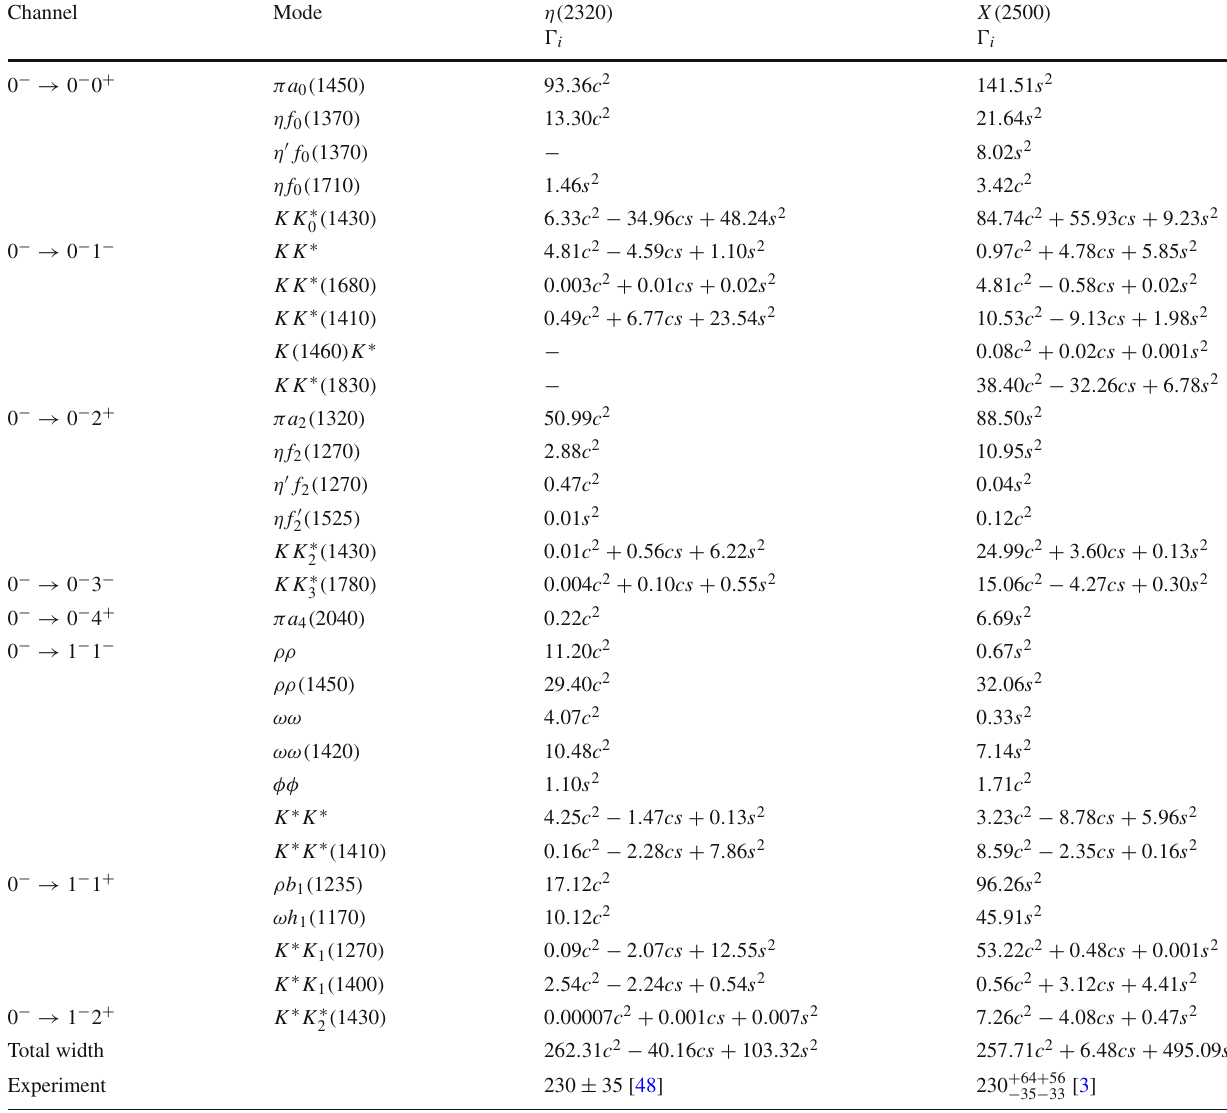
Table 4 Decay widths of the η( 2320 ) and X ( 2500 ) as the 5 1 S 0 isoscalar states with the RQM wave functions (in MeV). c ≡ cos φ, s ≡ sin φ . The masses of the η( 2320 ) and X ( 2500 ) are set to 2320 and 2470 MeV, respectively [3,48]. A dash indicates that a decay mode is forbidden Channel